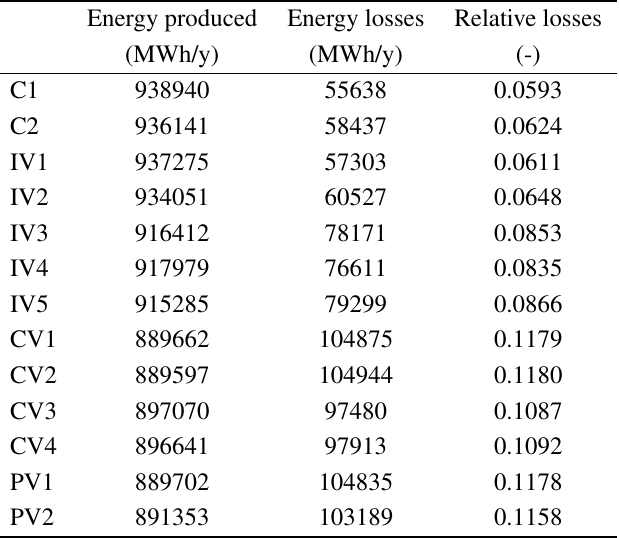
Table 4 . Energy produced and energy losses (200 MW, 100 km).